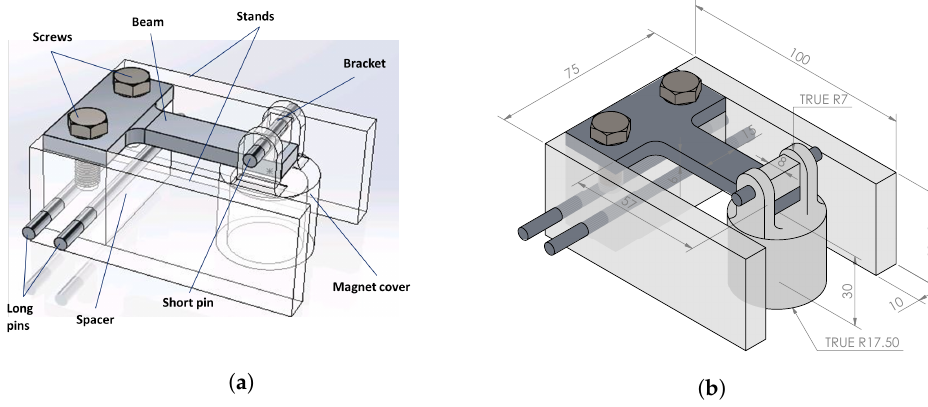
Figure 6. Sensor prototype details. ( a ) Sensor prototype parts; ( b ) Main dimensions of the prototype